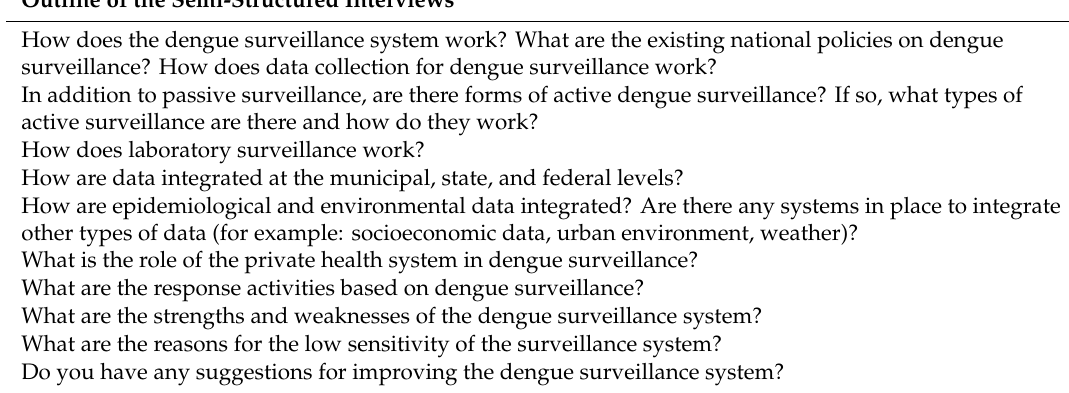
Table A1. Outline of the semi-structured interviews. Note that not all the questions were posed